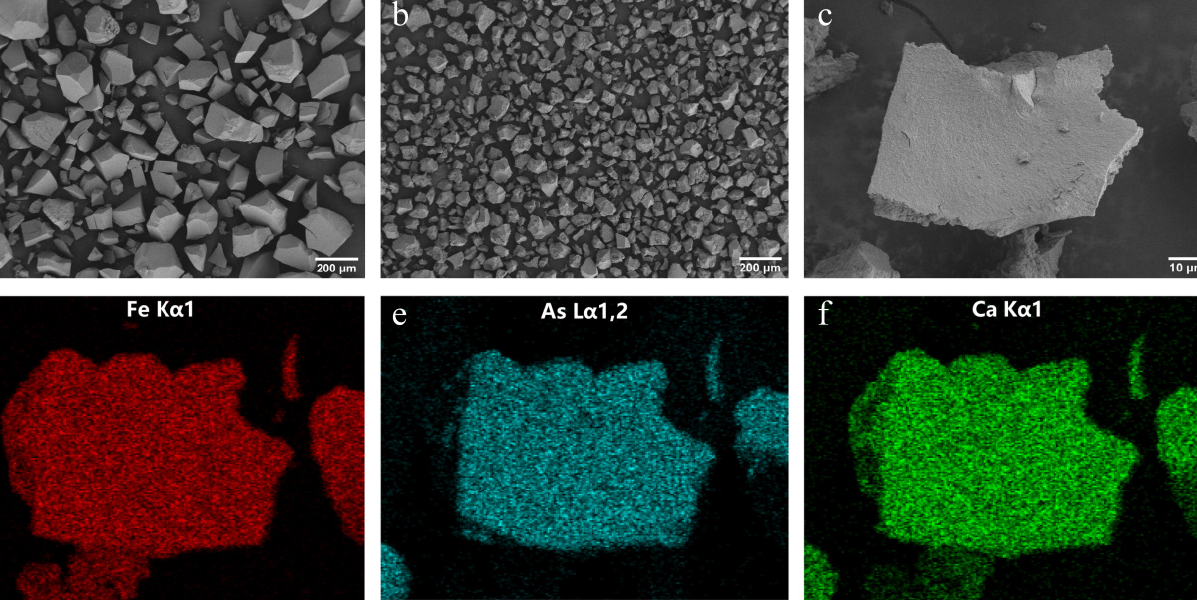
Figure 2. SEM morphology image of As-Fh ( a ) and As-Ca-Fh ( b ) before bioreaction. Selected EDS mapping areas ( c ) and elemental distribution of Fe ( d ), As ( e ), and Ca ( f ) of As-Ca-Fh. Table 2. The As/Fe and Ca/Fe atomic ratio before and after bioreduction obtained by SEM mapping.